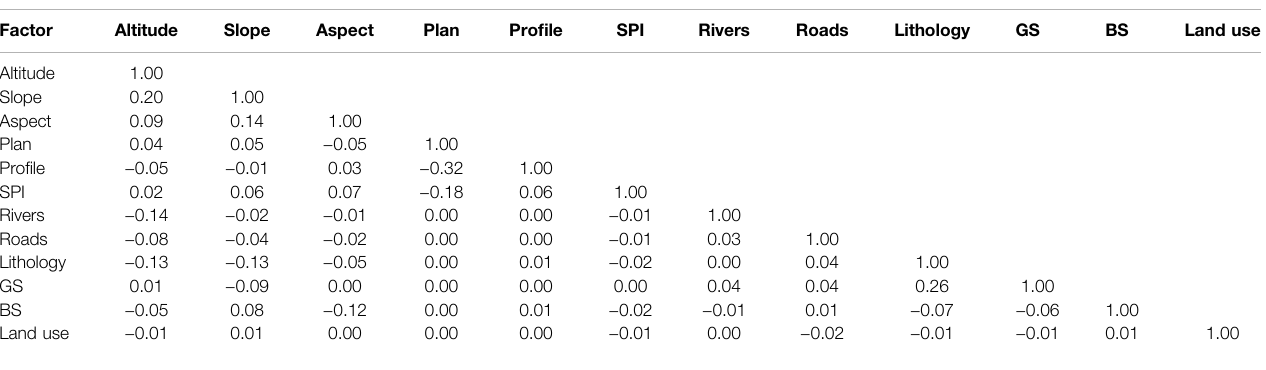
TABLE 5 | Spearman correlation coef fi cients of causal factors. Factor